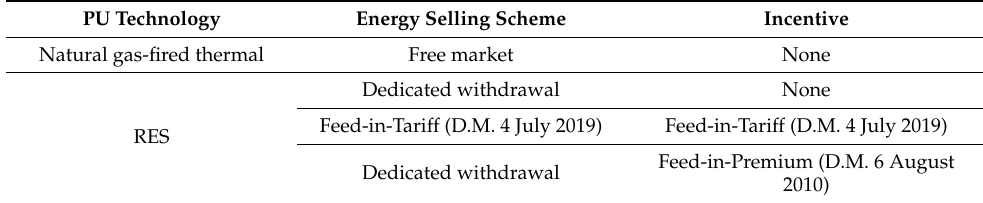
Table 2. Case studies considered in the